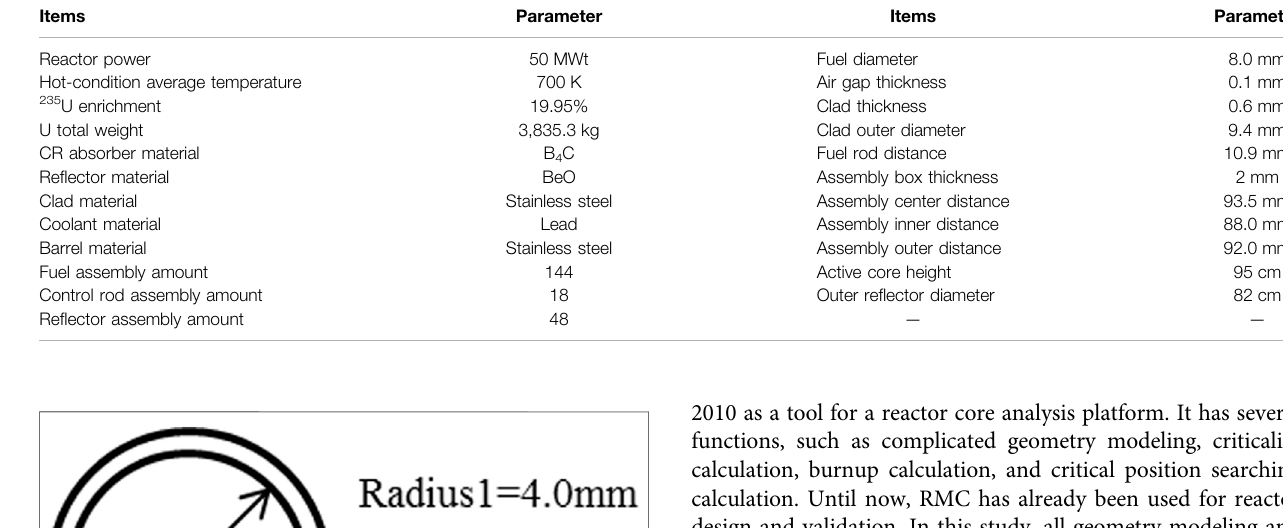
TABLE 1 | Basic parameters of the SLBR-50. Items